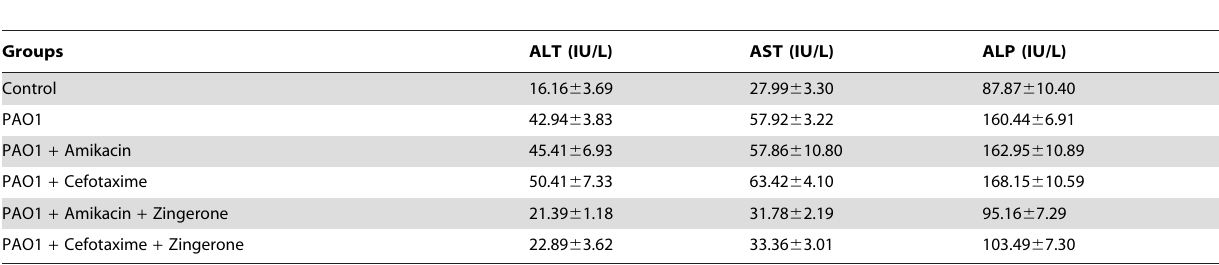
Table 2. Protective effect of zingerone on enzyme activities in serum (ALT, AST and ALP) against antibiotic induced endotoxemia after 6 hours on peak day of infection by P.aeruginosa PAO1.